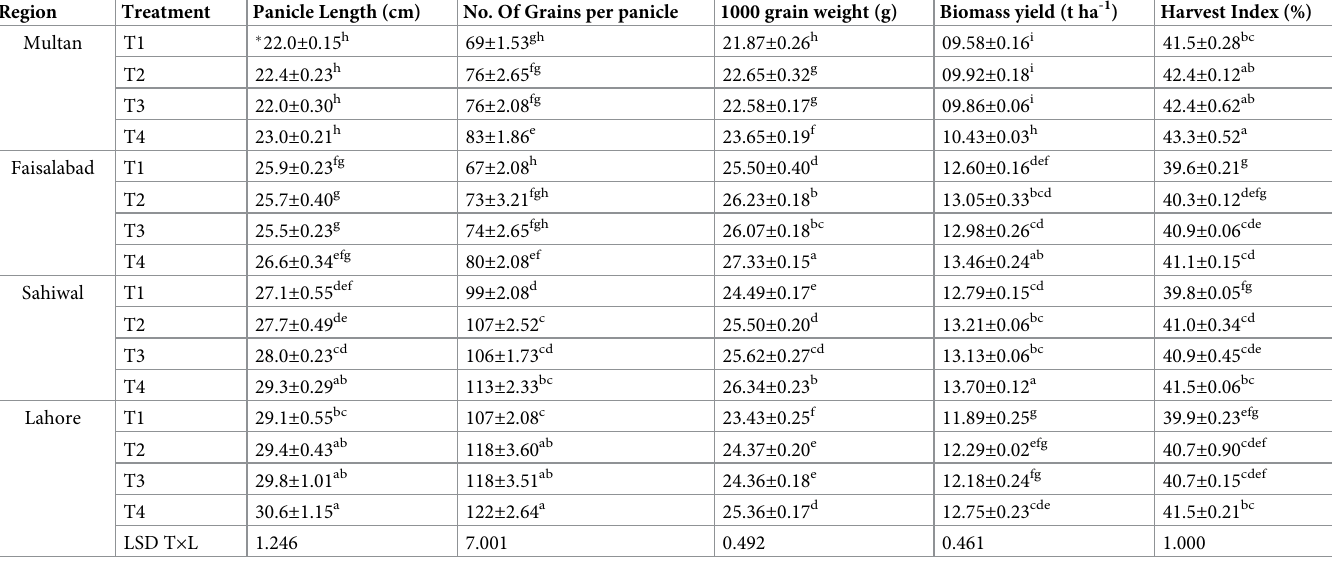
Table 2. Effect of zinc sulfate and bioactive zinc coated urea on growth and yield of rice. Region Treatment Panicle Length